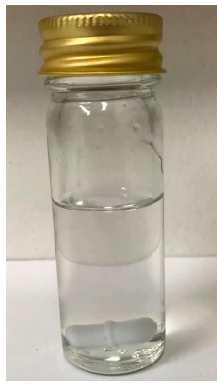
Figure 4. Cellulose acetate and polyethylene (CA/PEG) blended solution.